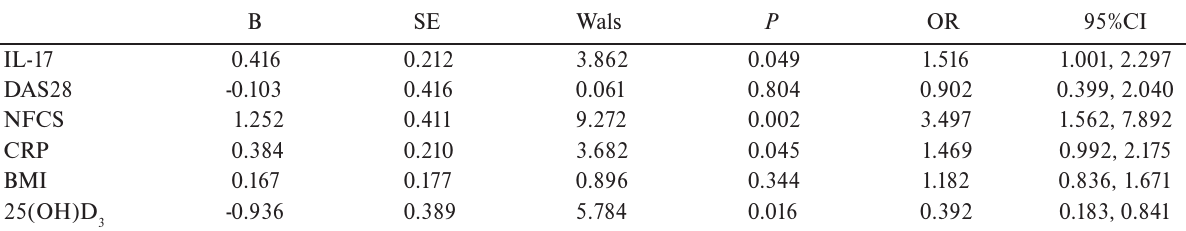
Table 3. Logistic regression analysis of the associated factors of sarcopenia in female RA